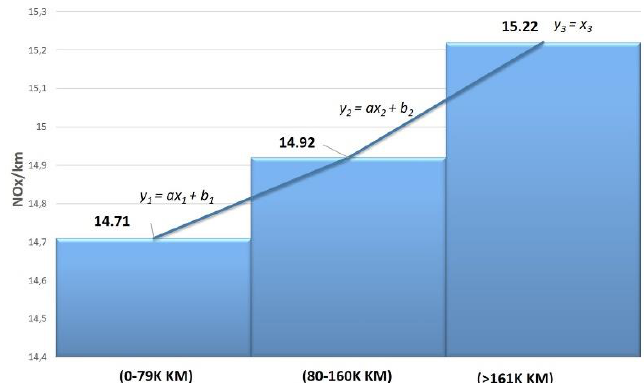
Figure 8. NO x emissions trend.